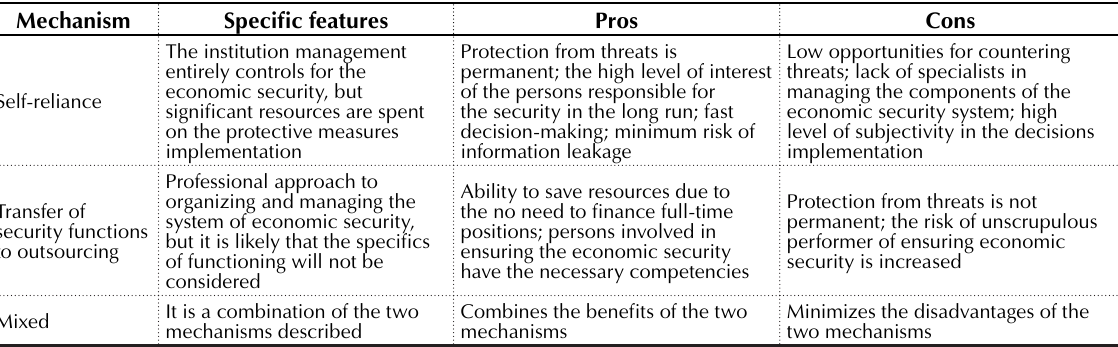
Table 3. Features of ensuring the economic security of financial